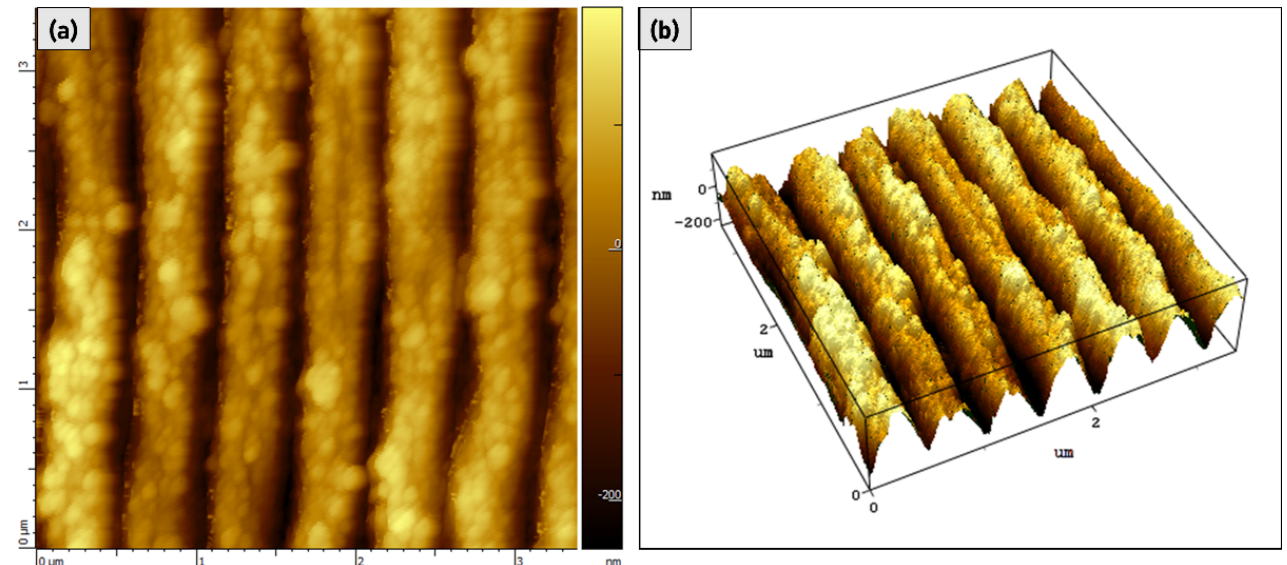
Figure 4. ( a ) AFM image (3.4 × 3.4 μ m) of the fabricated LIPSS on S1 sample. ( b ) AFM 3D-map of the scanned area in Figure 4a.